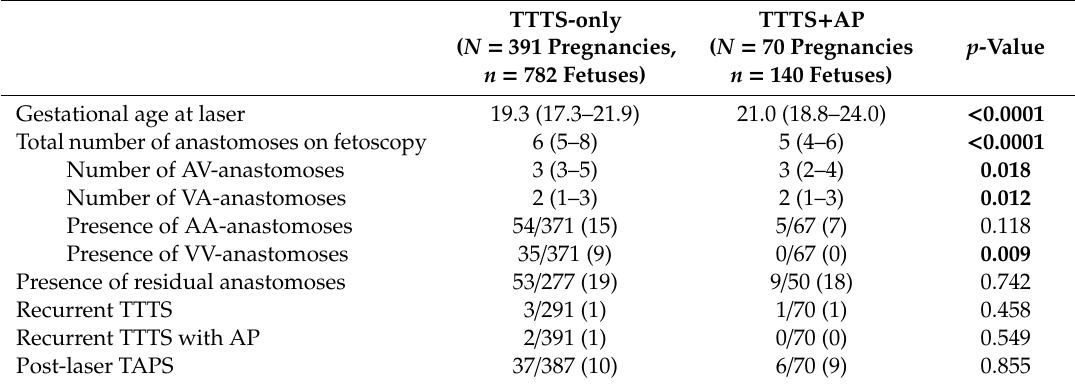
Table 2. Procedure-related characteristics for twins with TTTS-only and twins with TTTS + AP.